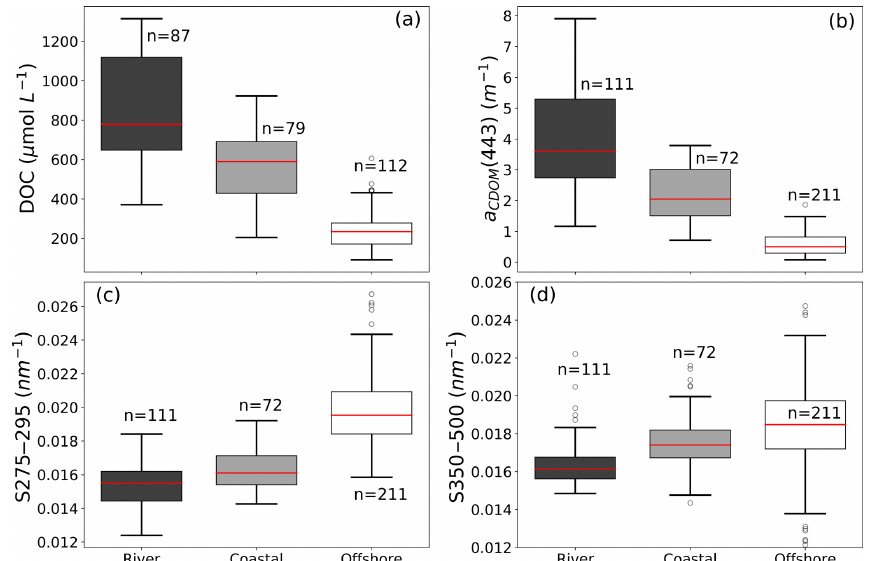
Figure 2. Box plot of (a) DOC concentration, (b) a CDOM (443), (c) S275–295 and (d) S350–500 for the three water types clustered by salinity (river < 0 . 2, coastal < 16, offshore > 16); the red line indicates median of each water type.